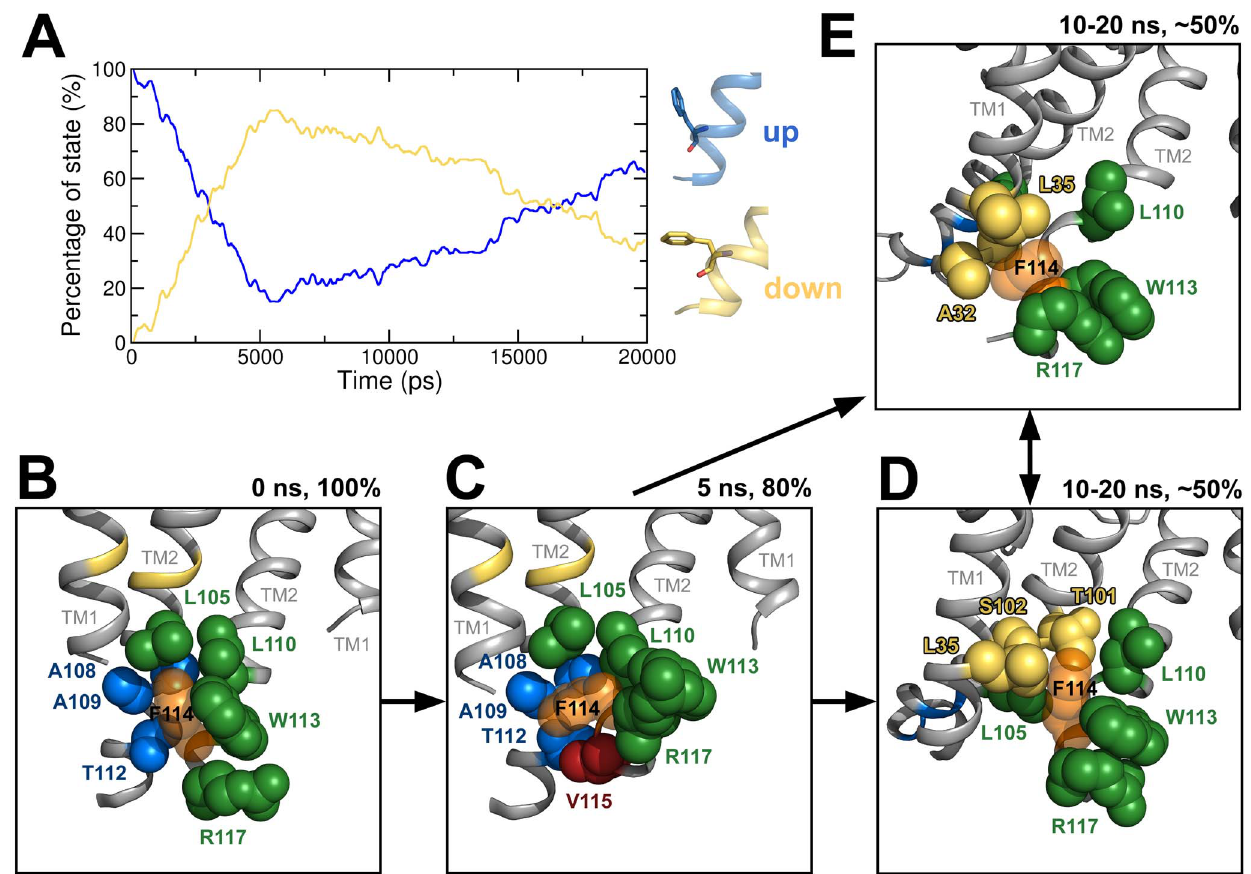
Figure 5. Analysis of x 1 angle dynamics of F114 and influence on packing. A) Percentage of F114 in the up (blue) and down (yellow) state over time. Packing of the F114 (transparent orange spheres) in the closed conformation (B), the transition state (C), the open states with F114 in the up (D) and the down state (E). Amino acids interacting in all states are shown in green. Interacting amino acids in the closed/open/transition state are represented in blue/yellow/red.